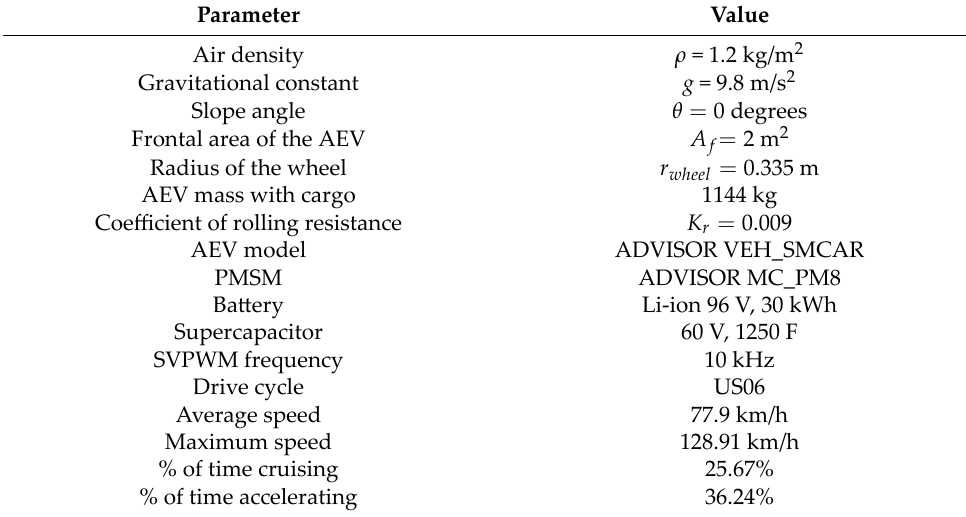
Table 2. Simulation parameters for testing the recommender system.